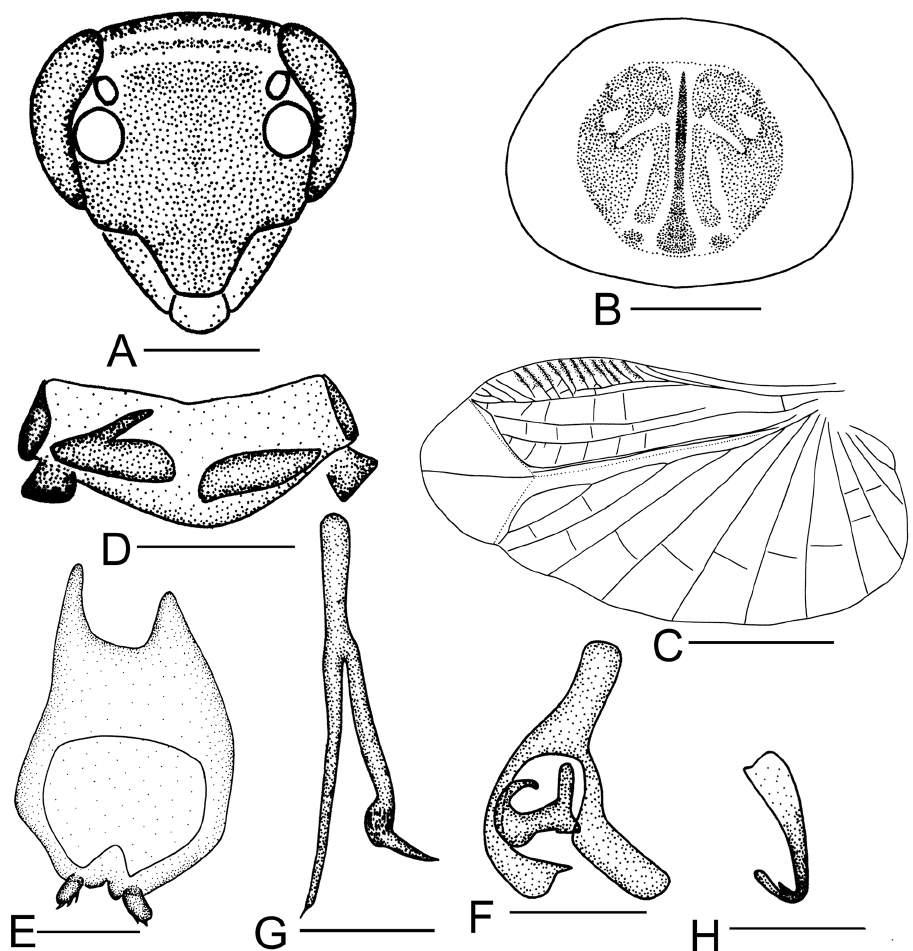
Figure 4. Sorineuchora shanensis (Princis, 1950) male from China, Yunnan, Pu’er, Simao. A head, frontal view B pronotum C hind wing (the dotted line indicates wing fold) D supra-anal plate, ventral view E subgenital plate, dorsal view F phallomere L1 G phallomere L2vm and R3 H phallomere R2. Scale bars: 0.5mm ( A, D–H ), 1.0 mm ( B ), 2.0 mm ( C